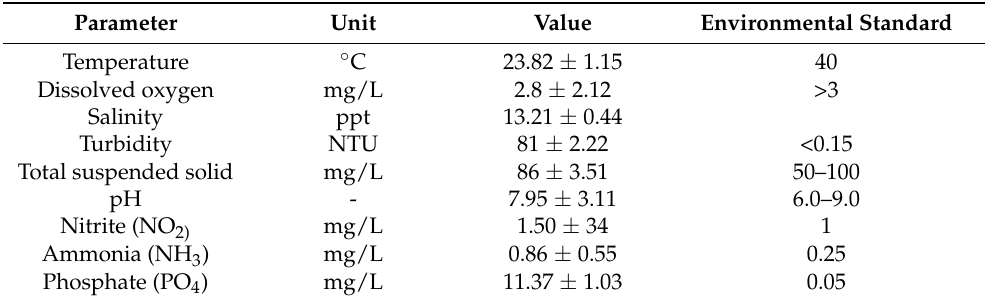
Table 2. Initial water quality parameters of aquaculture wastewater from Bachok farm,